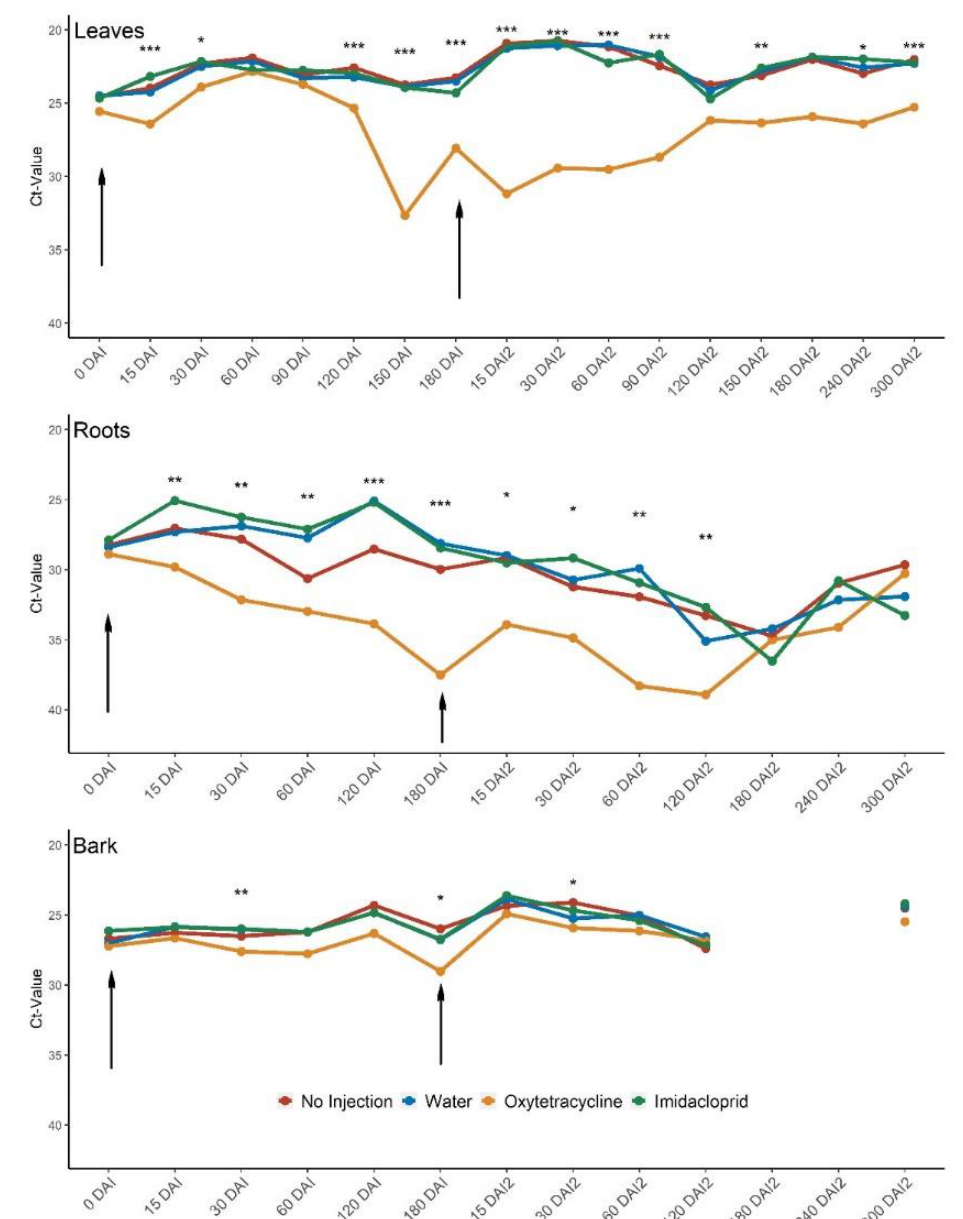
Figure 2. Root, leaf, and bark Ct-values after injection 1 and 2 (arrows) in October 2020 and April 2021, respectively. Bark tissue was not analyzed at 180 and 240 DAI. Asterisks indicate significant differences among treatments according to Tukey’s honest significant difference test; * p < 0.05; ** p < 0.01; *** p < 0.001. p -values and mean separations are provided in Table S1. Error bars are not shown for clarity. DAI = days after injection. 180 DAI = 0 DAI2.